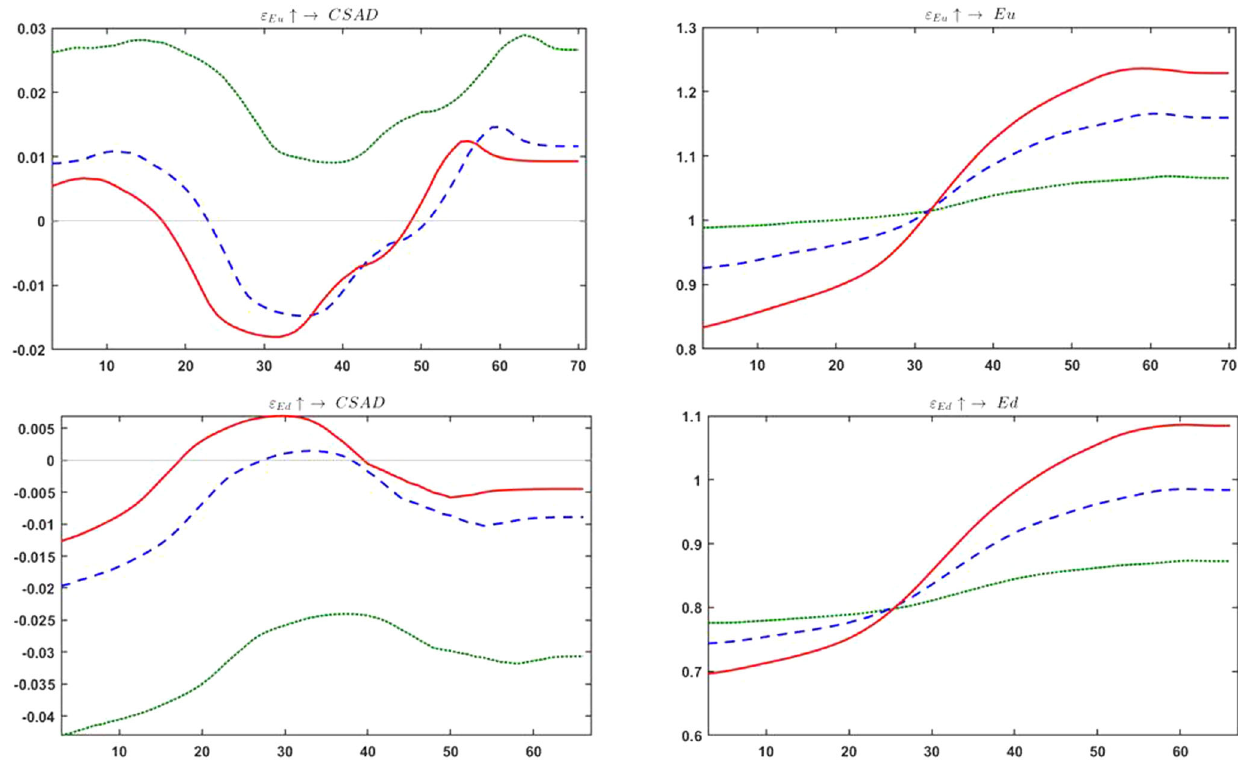
Fig. 5 Impulse responses in different ahead periods. The long-, medium- and short-term responses of market dispersion and internet postings to a unit shock in increasing postings or decreasing postings.